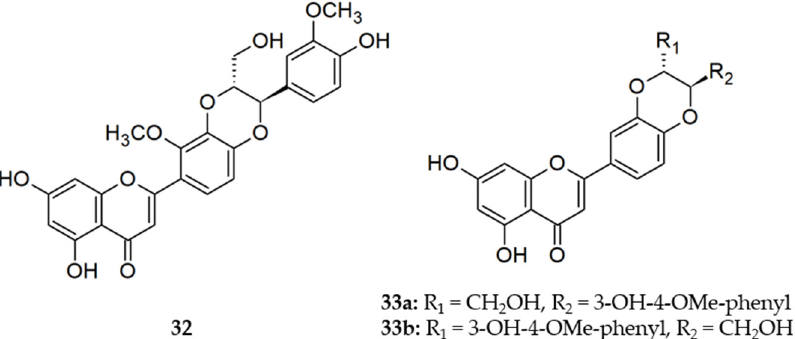
Figure 3. Structures of flavonolignans 32 and 33 (i.e., diastereomeric mixture of 33a and 33b )